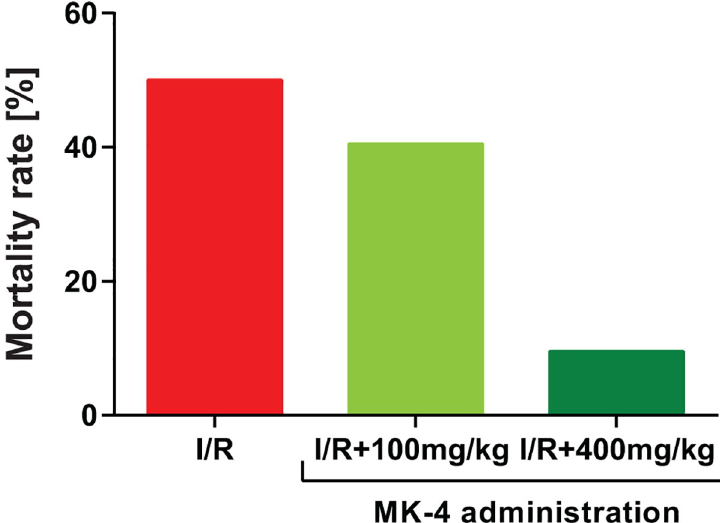
Fig 2. Positive effect of 400 mg/kg MK-4 administration on mortality rate in I/R rat model. Although administration of 100 mg/kg MK-4 following I/R showed a similar mortality rate compared to I/R group. The dose of 400 mg/kg MK-4 in two injections (200 mg/kg i.p. immediately and 200 mg/kg i.p. 2h after reperfusion) led to reduced mortality rate compared to I/R group.